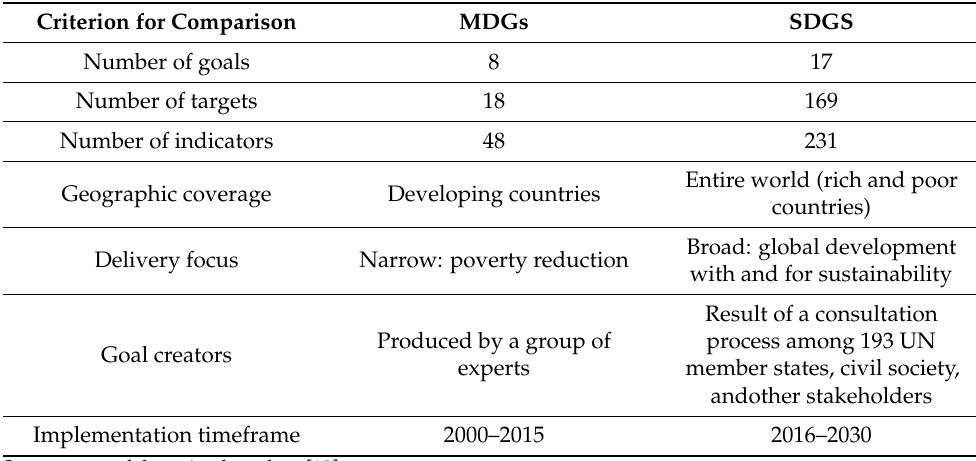
Table 1. The key differences between MDGs and